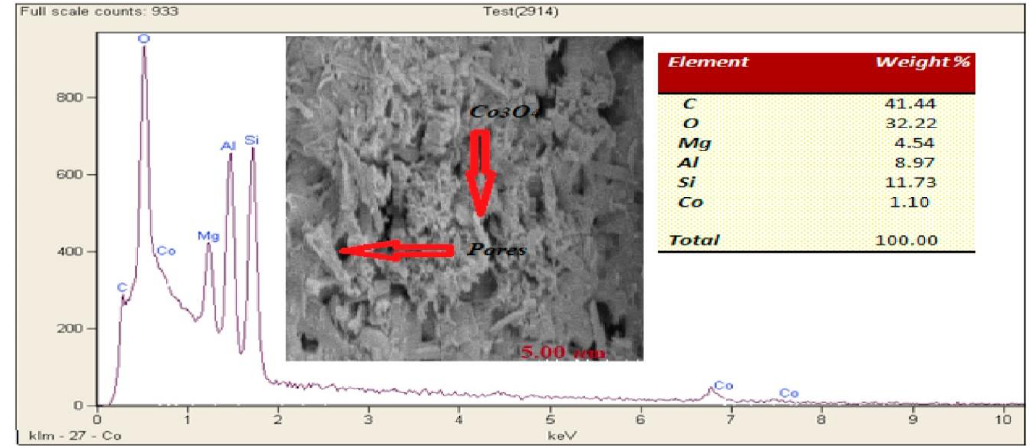
Figure 2. SEM/EDX spectra of monolith Co 3 O 4 supported adsorbents. Reproduced with permission from Silas et al. [67]. Copyright 2018 Elsevier Ltd. [67].